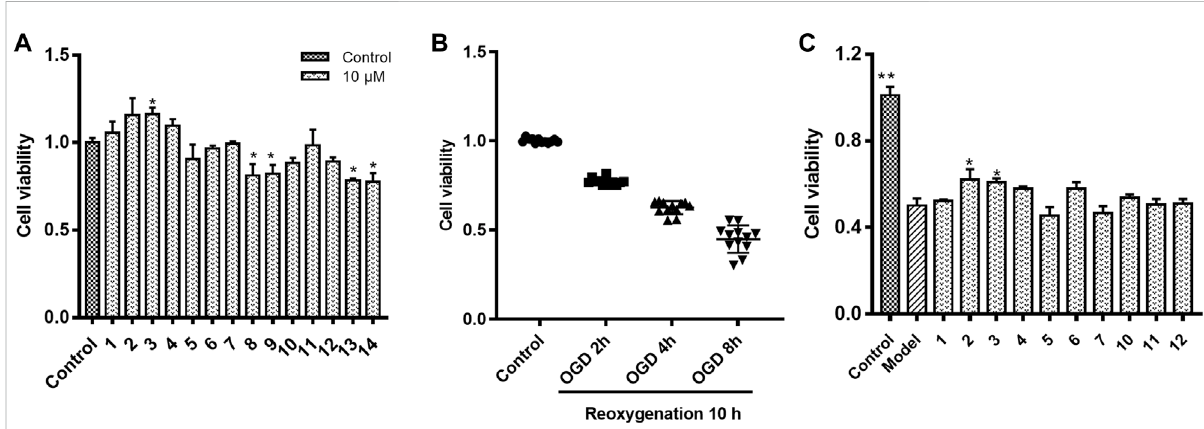
FIGURE 2 HUVECs viability indifferentculturecompositions. (A) HUVECs viability innormoxiccondition co-cultured withindividual chemicalconstituent of Saf fl ower; (B) HUVECs viability in oxygen-glucose deprivation (OGD) for 2, 4, or 8 h followed by reoxygenation for 10 h; (C) Protective effects of compounds 1 – 7 and 10 – 12 on HUVECs under OGD/R. *p < 0.05, ** p < 0.01 vs.